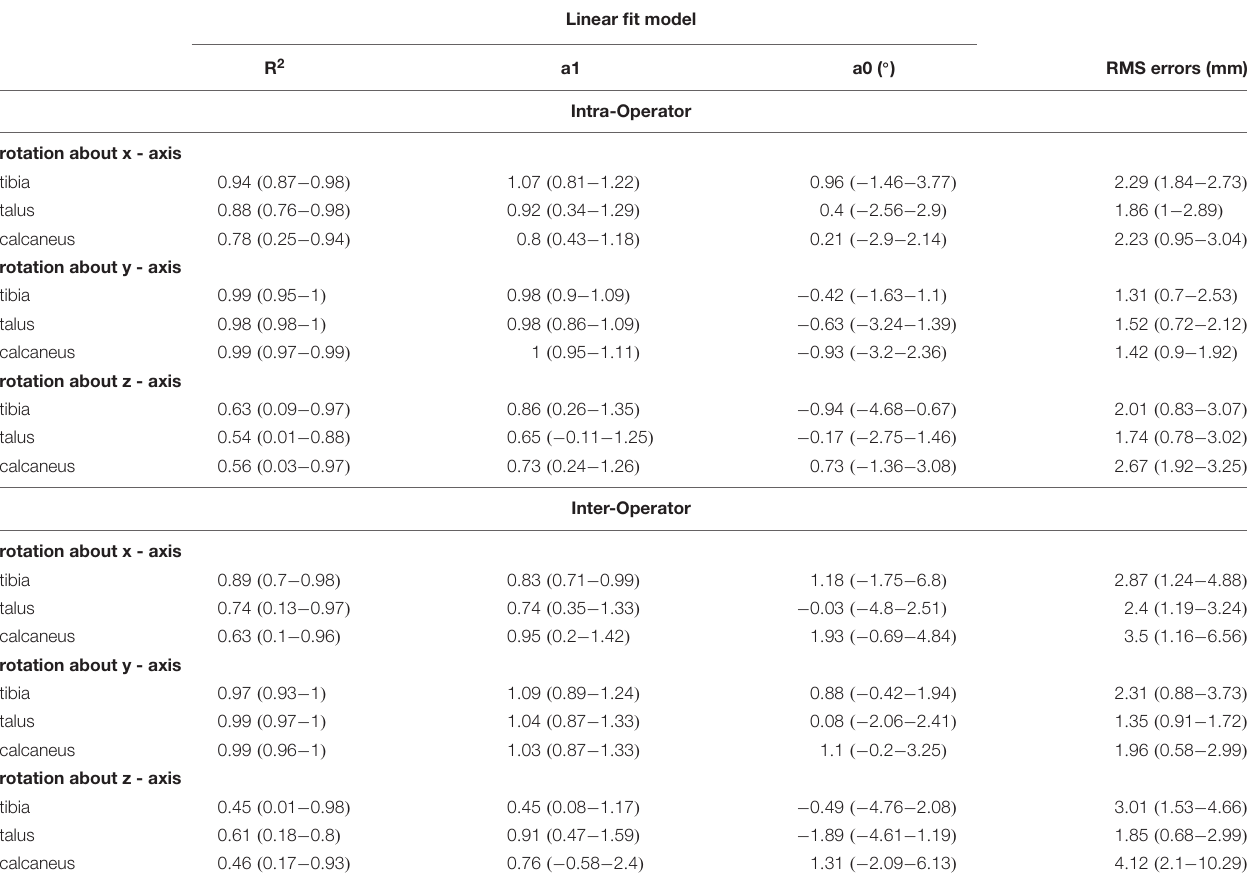
TABLE 2 | Intra- and inter- operator reliability scores for bone